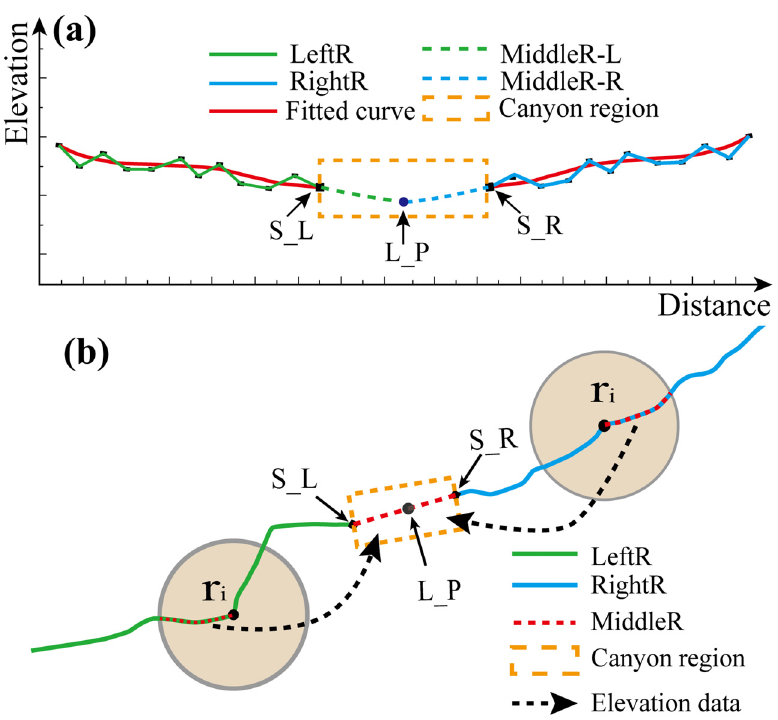
Figure 6. Description of the ridgeline restoration process above the transverse canyon. ( a ) Fitting a curve within the stack profile and splitting it into two parts, MiddleR-R and MiddleR-L, at the extreme point or midpoint L_P; and ( b ) obtaining the eligible curves r i of the ridgelines on both sides and fitting their elevation change data to the curves MiddleR-R and MiddleR-L, respectively, to restore the ridgeline MiddleR.